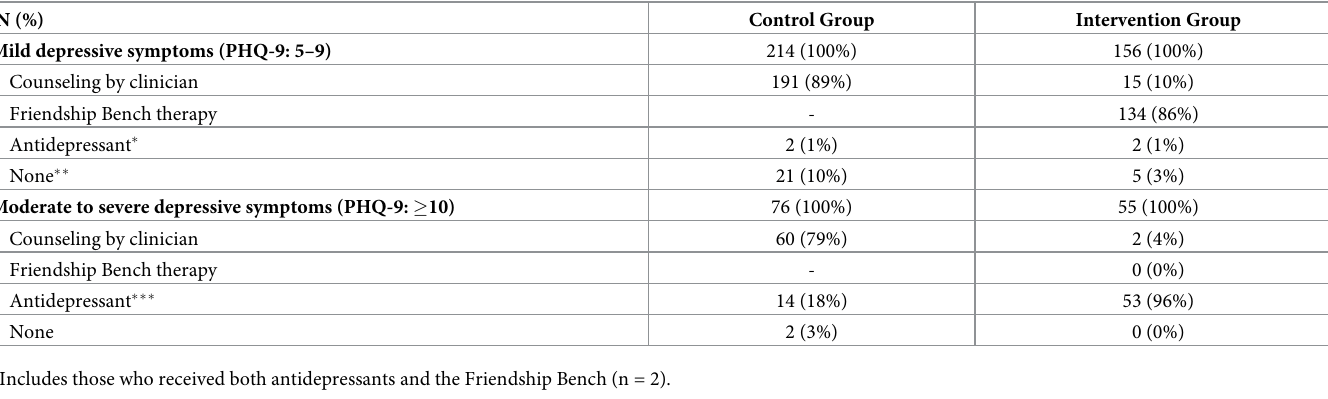
Table 3. Depression treatment initiation.